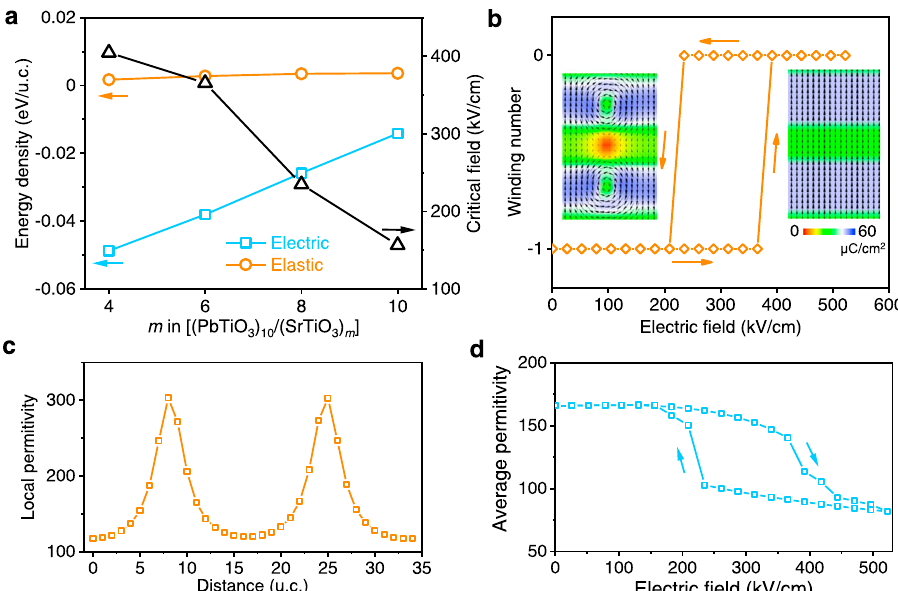
Fig. 4 Formation mechanism of antivortex in STO and its electric tuning via phase- fi eld simulation. a The electrostatic and elastic energy densities (on the left) for (PTO) 10 /(STO) m heterostructures and the critical electric fi elds (on the right) under which the antivortex disappears. b The hysteresis loop of winding number of STO within (PTO) 10 /(STO) 6 versus external electric fi eld. The left and right insets show the polarization distributions of vortex – antivortex pair and single-domain state, respectively. c The spatial distribution of local permittivity in the middle plane of STO across the antivortex cores. The two peaks indicate the signi fi cant increase of the permittivity at the antivortex cores. d The average permittivity in the middle plane of STO versus the external electric fi eld. The two abrupt changes of permittivity in the hysteresis loop are induced by the topological phase